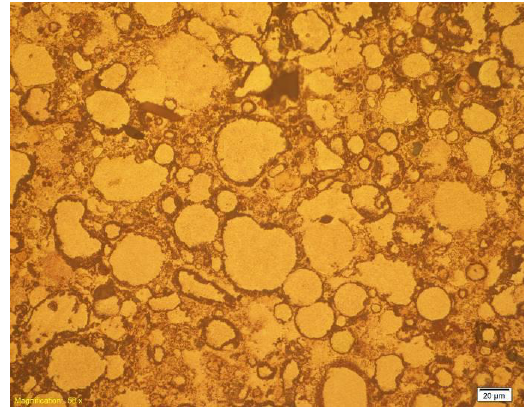
Figure 2. Microstructure of the forged SPS bronze (×500).